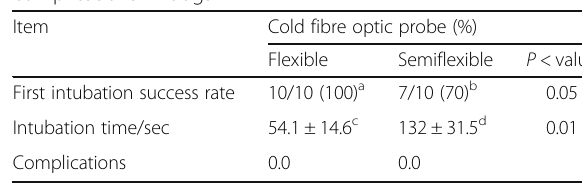
Table 1 Effect of type of cold fibre optic probe on success rate and endotracheal intubation time, and incidence of